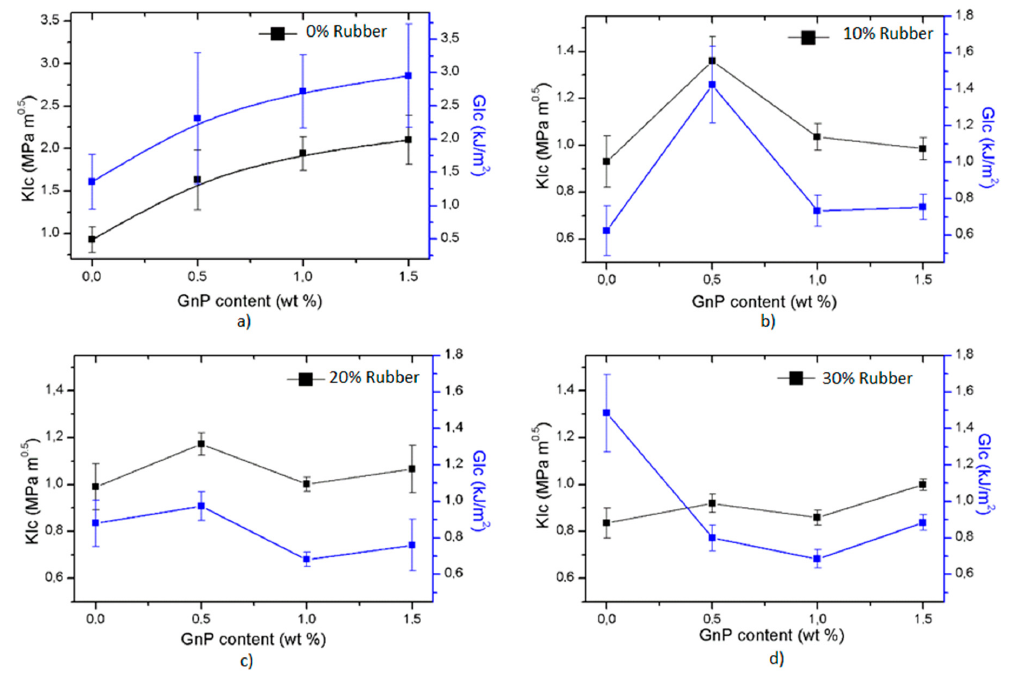
Figure 7. Variation of fracture toughness with GnPs for ( a ) 0% rubber, ( b ) 10% rubber, ( c ) 20% rubber, ( d ) 30% rubber.